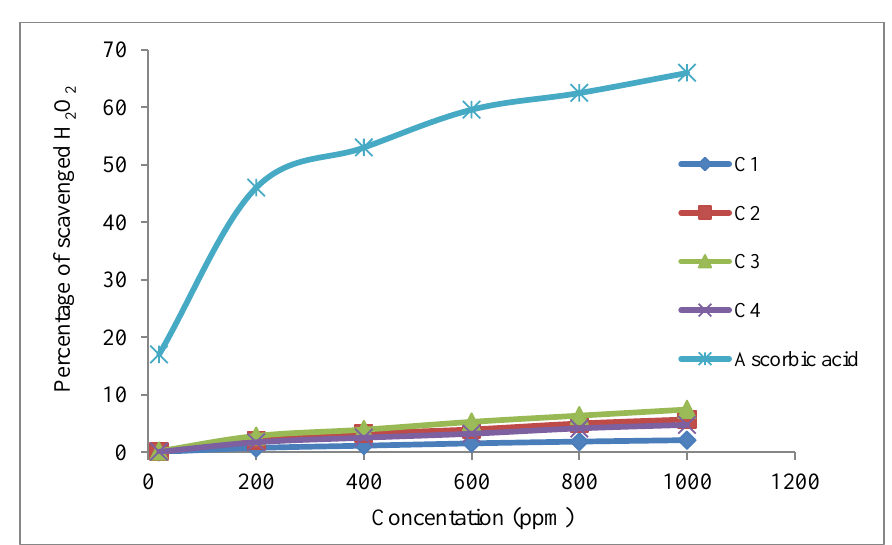
Figure 12. Comparison of H 2 O 2 Scavenging activity of C 1 , C 2 , C 3 , C 4 and Ascorbic